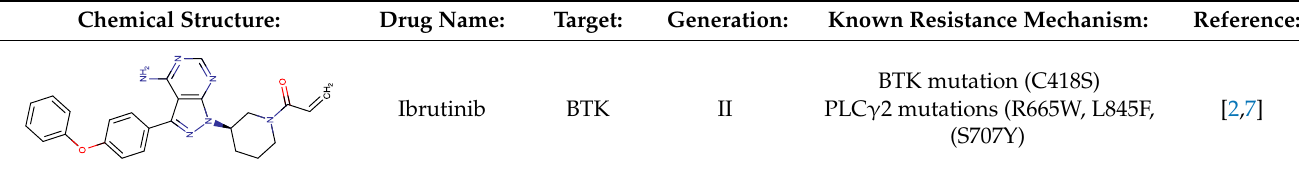
Table 1. Single kinase inhibitors currently available.